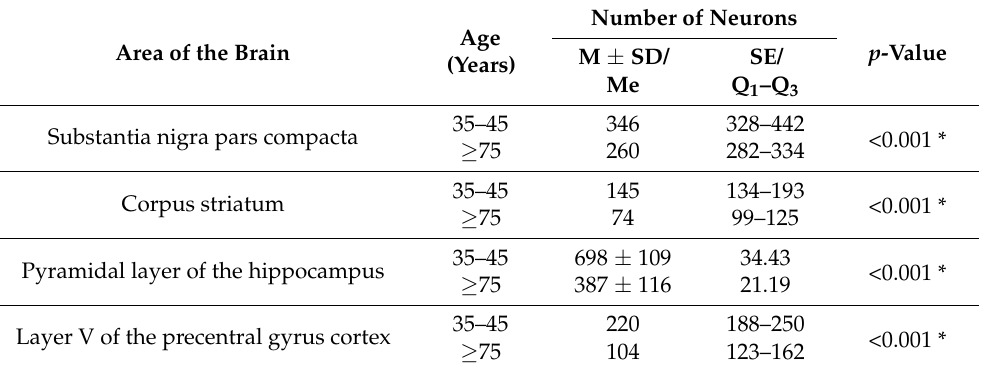
Table 1. Morphometric results on the number of neurons in various brain structures in the studied age groups.